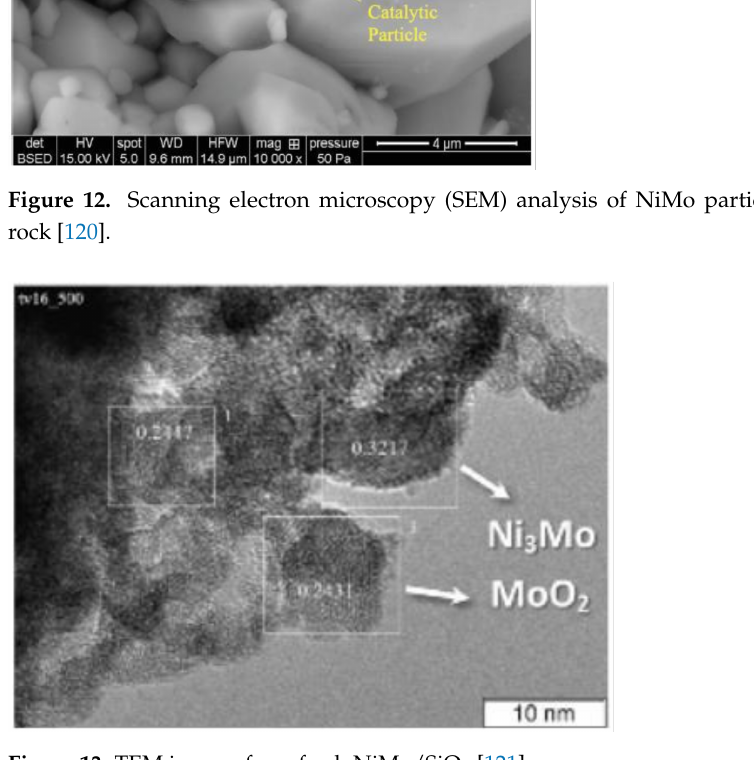
Figure 13. TEM images from fresh NiMo/SiO 2